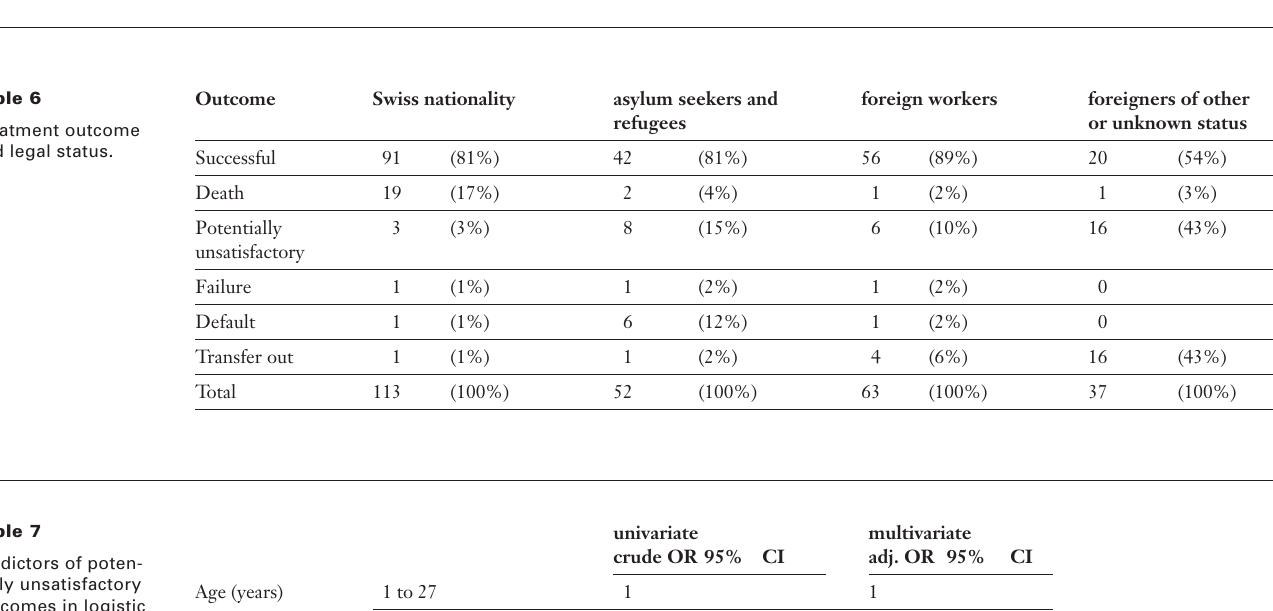
Predictors of poten- tially unsatisfactory outcomes in logistic regression